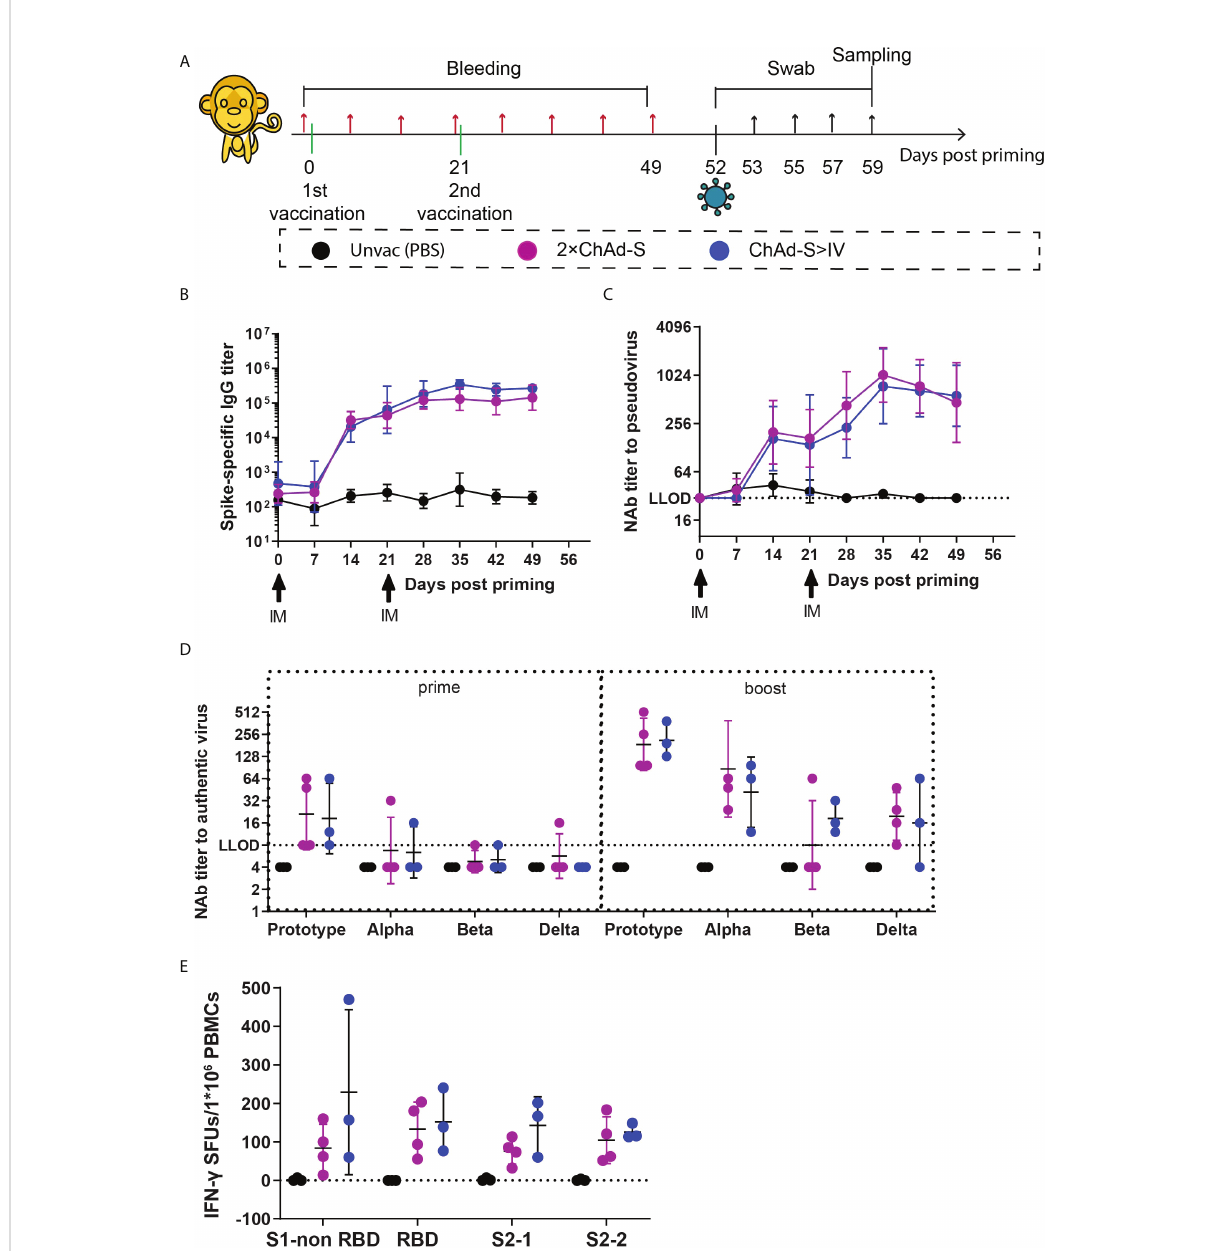
FIGURE 2 Immune responses induced by homologous ChAd-S or heterologous ChAd-S plus IV in NHPs (A) . Schematic representation of the experimental protocol. Female rhesus macaques were immunized with 2 doses of ChAd-S (2×ChAd-S, n = 4), or prime with ChAd-S and boost with IV (ChAd-S>IV, n = 3). “ Unvac ” was unvaccinated group and set as the blank control. For all NHPs, blood was collected before immunization and every 7 days post priming. On day 52, NHPs were challenged with Beta variant (B.1.351). Nasal swabs and throat swabs were collected at dedicated time point as shown, and all NHPs were sacri fi ced on day 7 post challenge for trachea, bronchus, lung, and BAL. (B – D) Humoral immune responses, including the dynamic titer of sera spike protein-speci fi c IgG (B) , dynamic NAb titer measured by pseudovirus (C) , and cross-neutralizing antibody titer against Prototype, Alpha, Beta and Delta (D) . NAb titers were expressed as 50% effective dilution (ED50) of serum. (E) Spike-speci fi c T cell responses of PBMC were measured by IFN- g ELISPot assay, and expressed as SFU per 1×10 6 lymphocytes. Bars represent the geomean ± geometric SD for (B – D) , mean± SD for (E)